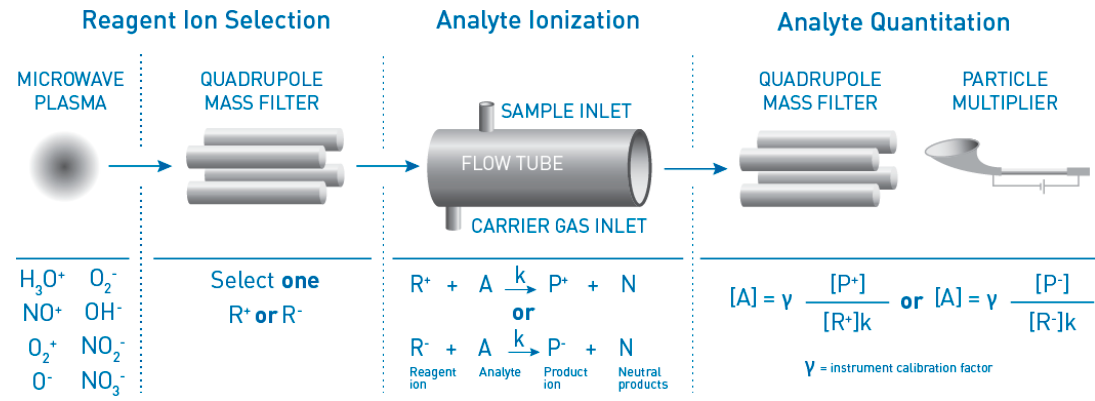
Figure 1. Schematic representation of the SIFT-MS analytical technique, which is based on direct, soft sample ionization with atomic and molecular ions. Used with permission of Syft Technologies Limited.